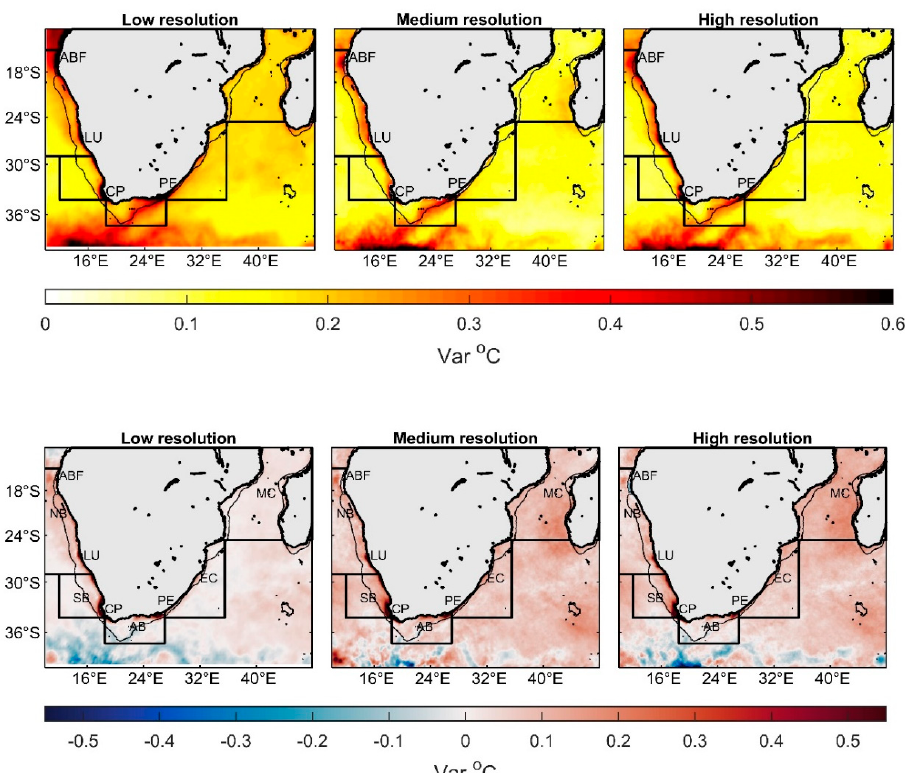
Figure 2. (Top panel) Variance ( ◦ C 2 ) and (bottom panel) seasonal bias of variance (summer climatology–winter climatology), for low (0.25 ◦ ), medium (0.1 ◦ ) and high (0.05 ◦ ) spatial resolu- tion sea surface temperature ( SST ) products for the southern African marine region. The black boxes show the five defined sub-regions; the northern Benguela (NB), southern Benguela (SB), Agulhas Bank (AB), East Coast (EC) and Mozambique Channel (MC). The labels ABF, LU CP and PE represent the Angola–Benguela Front, Lüderitz, Cape Peninsula and Port Elizabeth regions, respectively. The thin black contour shows the 1000 m